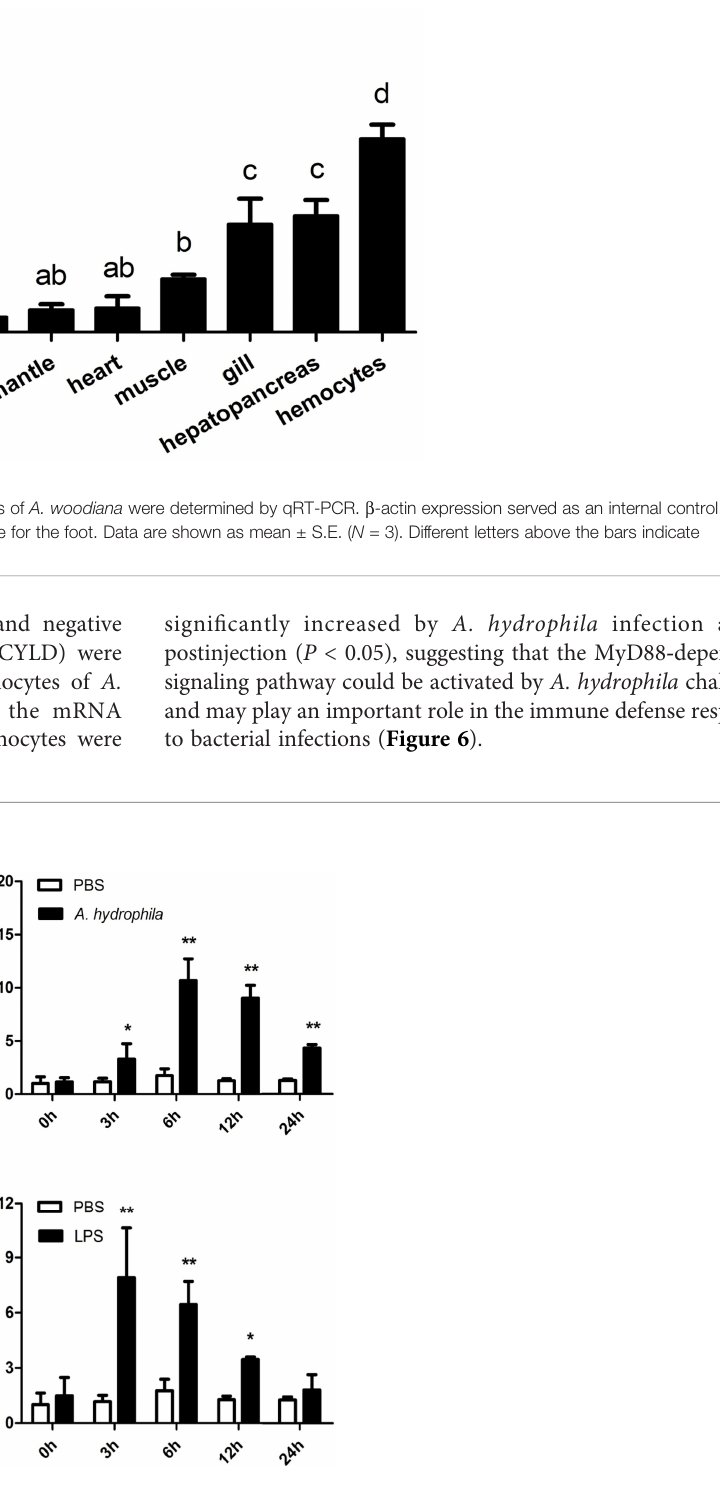
FIGURE 4 | Expression pro fi les of Aw MyD88 in primary cultured hemocytes infected with A. hydrophila (A) or LPS (B) in vitro . The b -actin gene was used as the internal control to calibrate the cDNA template for all the samples. The expression level of the control group (PBS) at 0 h postchallenge was set as 1.0, and the results are shown as mean ± S.E. ( N = 3). Signi fi cant differences between the immune challenge and control groups are indicated by the asterisks (* and ** represent P < 0.05 and P < 0.01, respectively).